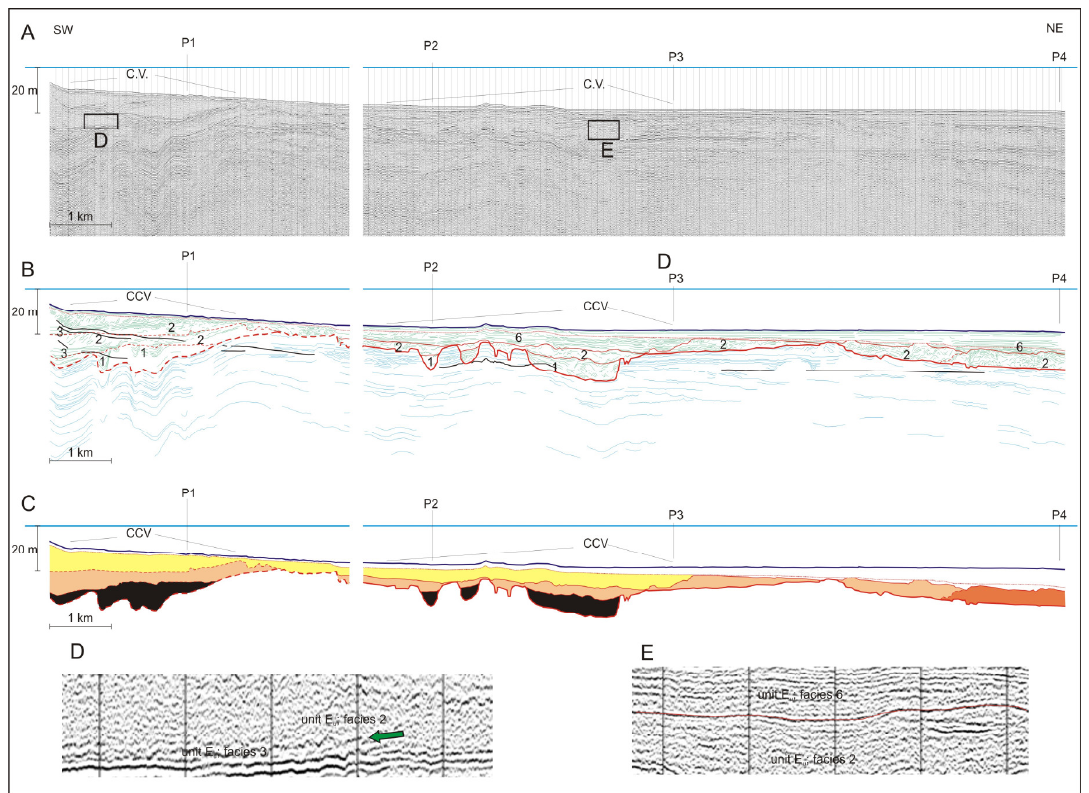
Figure 10. Part of seismic profile T8. Seismic section ( A ), its interpretation ( B ), seismic units recognised ( C ), and enlargement of some significant sectors of the unconformities between units, with some transitions between different seismic facies ( D,E ). This profile intercepts two parts of the CCV. In the landward side of the profile, note the superimposition of unit E u and unit G u , which are two successive barrier/spit-backbarrier systems. In both systems, as the transgression progressed, the barrier/spit retreated landwards and covered the backbarrier sediments through over-wash and/or tidal inlet deposits, as evidenced by the reflectors in seismic facies 2b down-lapping landwards onto the plane-parallel reflector of seismic facies 3.